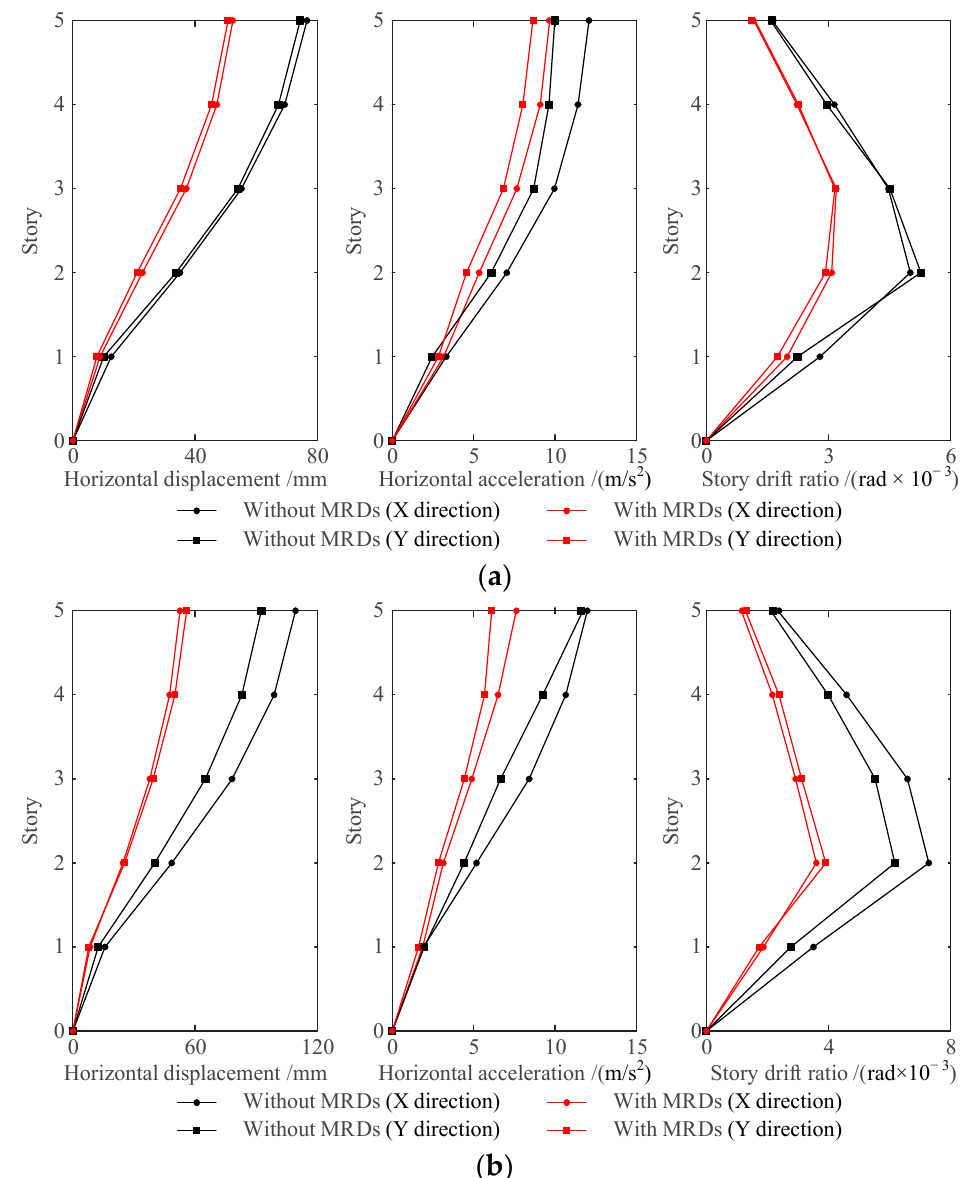
Figure 11. Envelope diagram of maximum horizontal displacement, acceleration and story drift ratio of RC frame structure. ( a ) Under the action of El-Centro wave; ( b ) under the action of Tangshan wave.